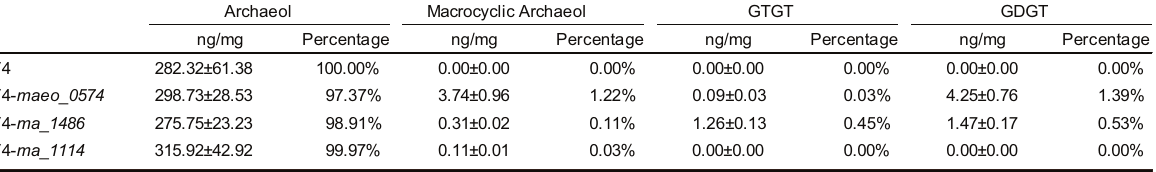
Fig. 3 Quanti fi cation of lipids formation during Tes expression in M. maripaludis . The abundance of core GDGT-related lipids (ng/mg dry cell mass) from heterologous expression of Tes genes maeo_0574 , ma_1486 , or ma_1114 , showing maeo_0574 is more ef fi cient to synthesize GDGT and related lipids than the other homologs. The abundance of core lipids was calculated relative to the peak area of the synthetic C46 GTGT internal standard (5). Results are the mean ± standard error from three biological replicates. Source data are provided as a Source Data fi